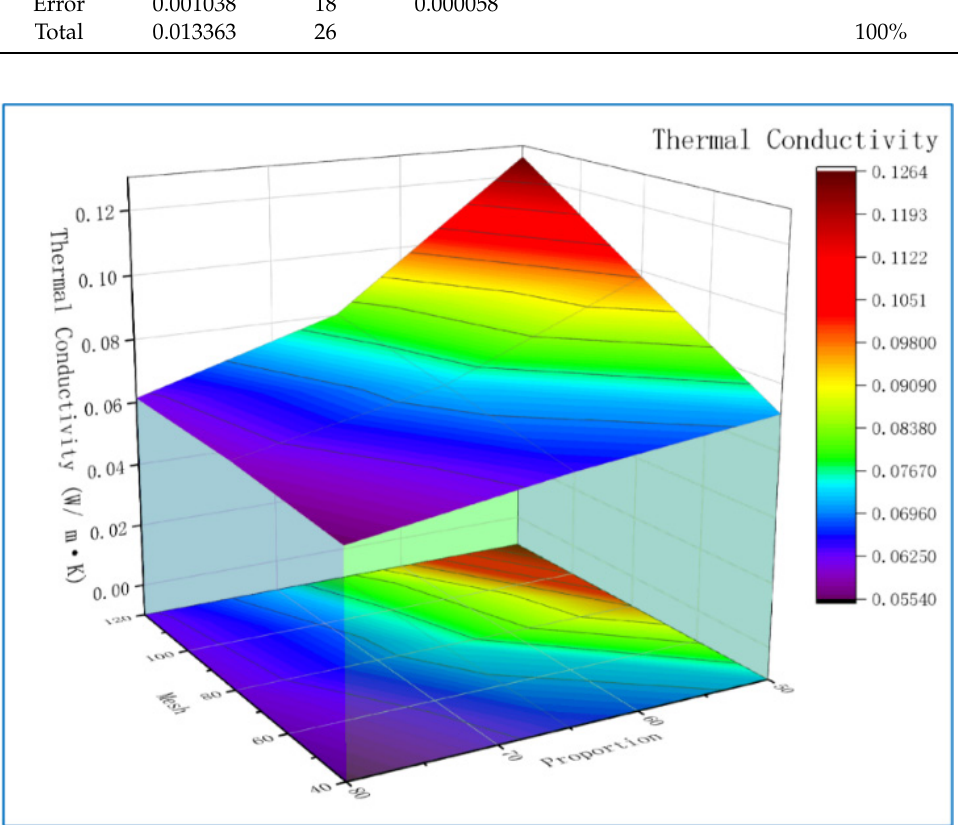
Figure 9. The surface projection of Mesh and Proportion affects thermal conductivity.